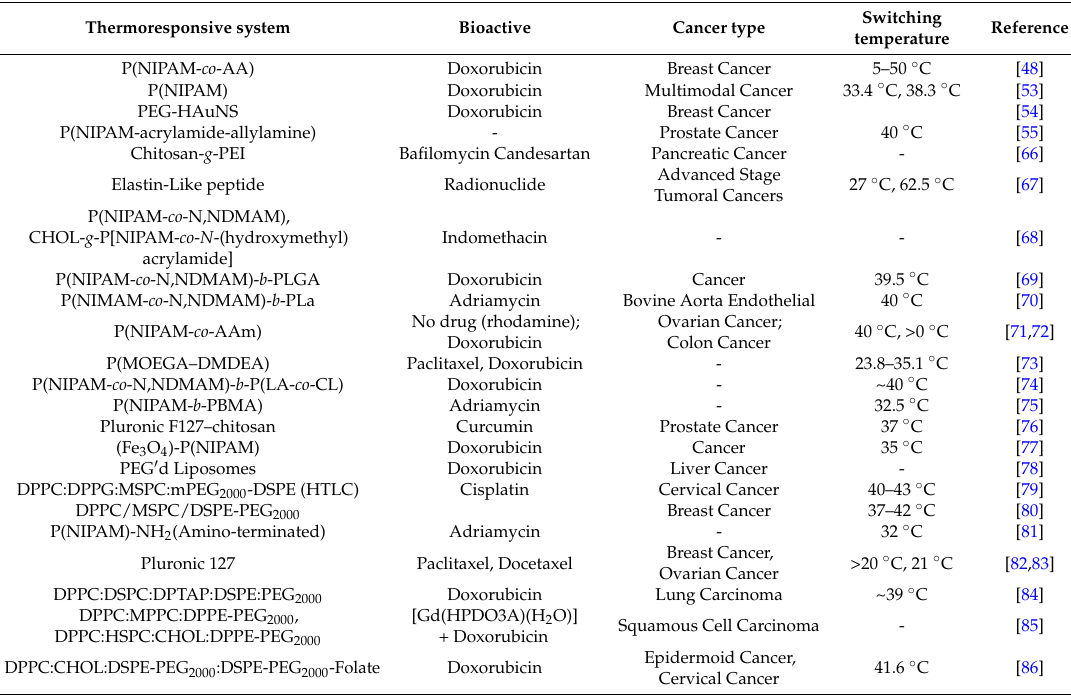
Table 1. Thermoresponsive systems in cancer